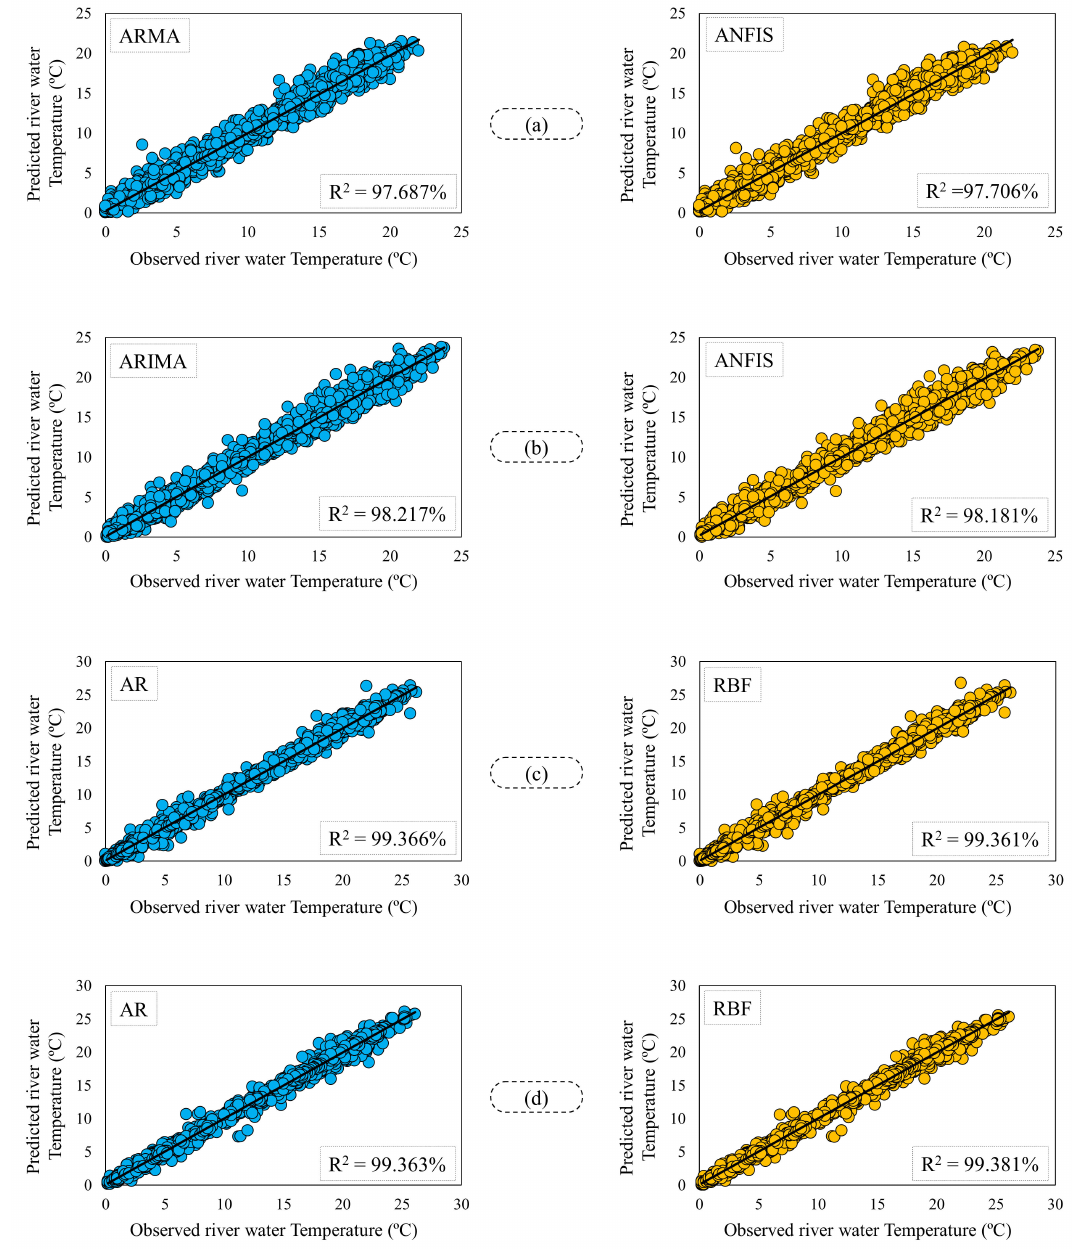
Figure 7. Scatter plots comparing the predictions of stochastic and artificial intelligence models, with their observation values (left side—the best model among stochastics; right side—the best model among artificial intelligences): ( a ) Bobry, ( b ) Sieradz, ( c ) Pozna´n and ( d ) Gorzow